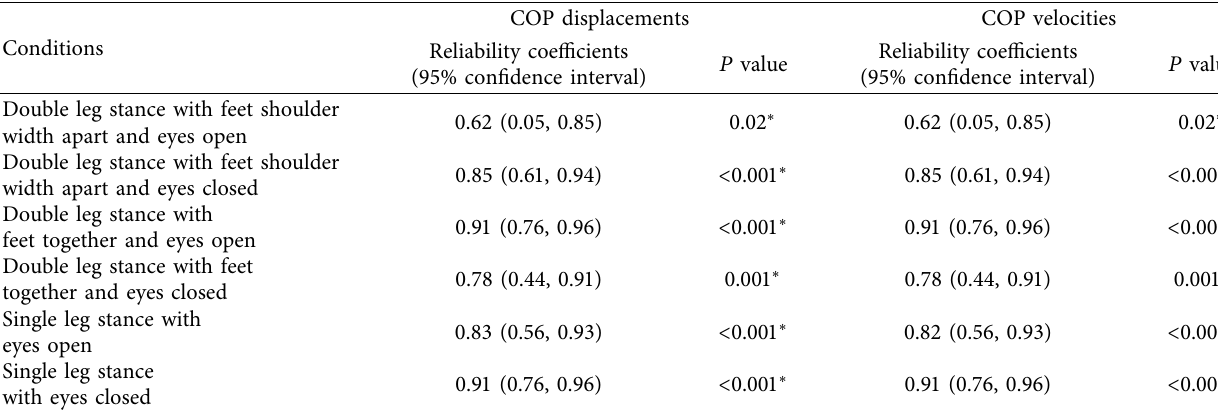
Table 2: Results of test-retest reliability (intraclass correlation coefficients) for COP displacements and velocities between sessions 1 and 2 in six conditions.